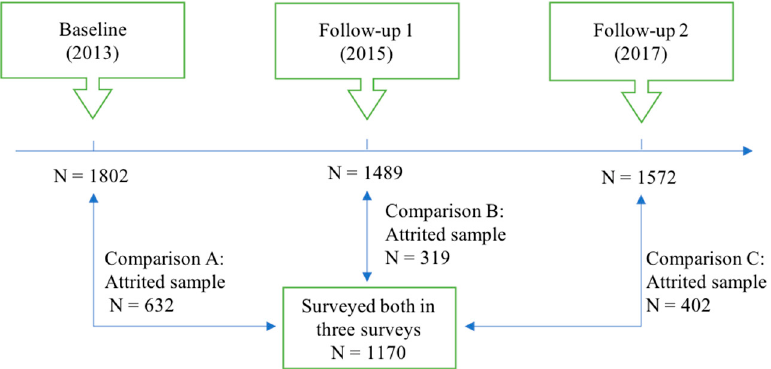
Figure A1. Sample size of each survey round.